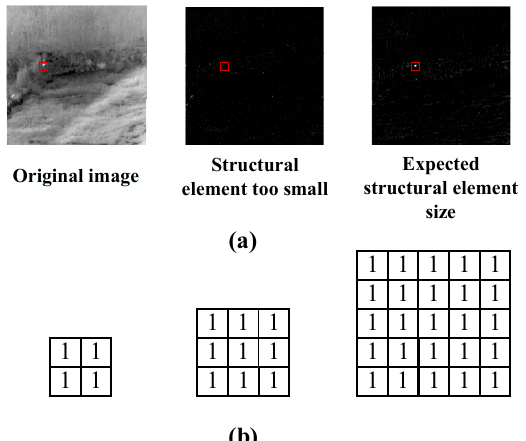
Figure 2. ( a ) Comparison of detection failure and expected size of structural elements due to structural elements which are too small; ( b ) three structural elements selected in this algorithm.